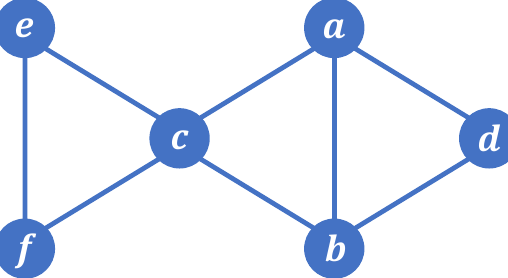
Figure 1. An example for CCLP, where S CCLP ( a , b ) > S CCLP ( e , f ) .